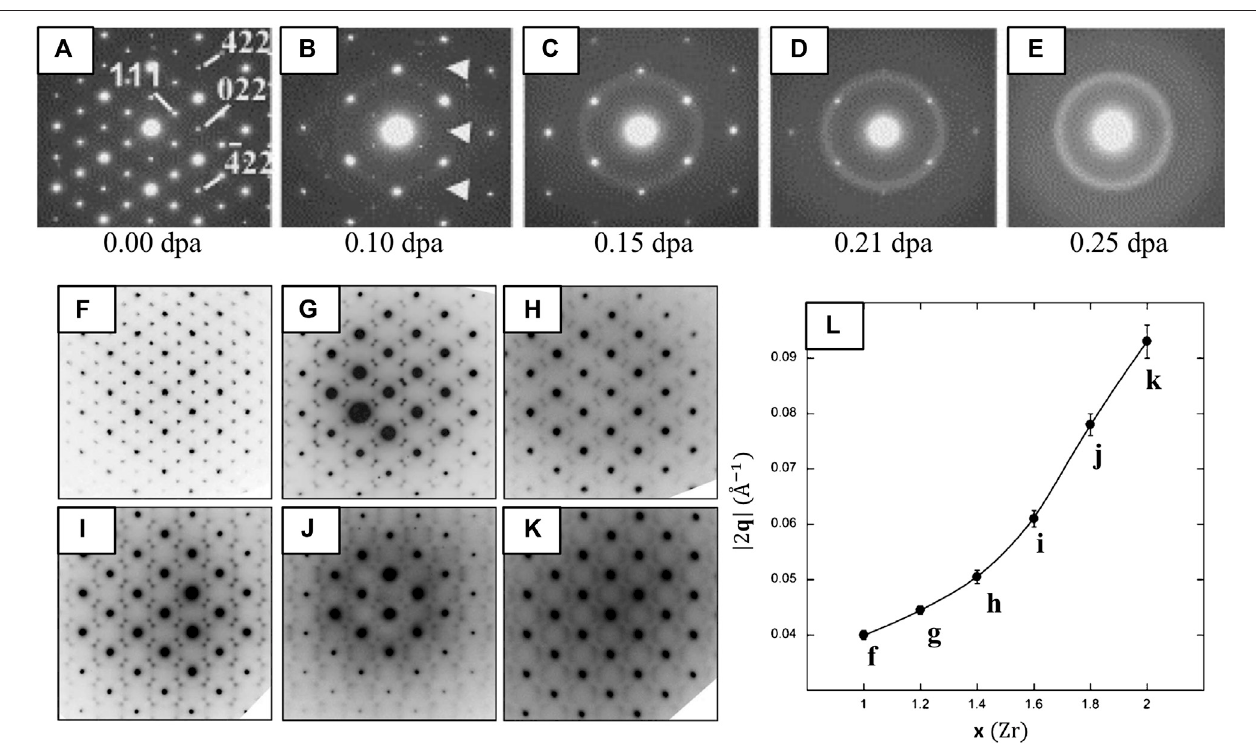
FIGURE 9 | SAED patterns illustrating ODT of ordered pyrochlores (A – E) due to ion-irradiation and (F – L) chemical doping. (A – E) SAED diffraction patterns of Er 2 Ti 2 O 7 [011] subjected to Kr + irradiation at increasing dose. The loss of diffraction maxima with indices h + k + l (cid:2) 4 n (i.e., 022 and 422) (white arrows) suggests anion disordering occurs upon irradiation, followed by cation disordering and loss of long-range order with increasing dose, reproduced from (Lian et al., 2003). (F – L) SAED patternsofY 2 Sn 2 − x Zr x O 7 [110]forincreasingZrcontent( x )where (F) x (cid:2) 1.0(Y 2 Sn 1.0 Zr 1.0 O 7 ) (G) x (cid:2) 1.2 (H) x (cid:2) 1.4 (i) x (cid:2) 1.6 (J) x (cid:2) 1.8and (K) x (cid:2) 2.0(Y 2 Zr 2 O 7 ). (L) A plot of | 2 q | versus Zr content, where | 2 q | represents the characteristic spacing between pairs of satellite re fl ections. The real-space correlation distances for the minimum ( x (cid:2) 1.0, | 2 q | − 1 (cid:2) 11 ± 0.8 Å) and maximum ( x (cid:2) 2.0, | 2 q | − 1 (cid:2) 3 ± 0.2 Å) Zr contents. Reproduced from reference (de los Reyes et al.,